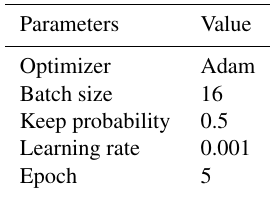
Table 3. Parameter settings of the RNN model. Table 4. Validation set results of the SVM, GBDT, and RNN mod-